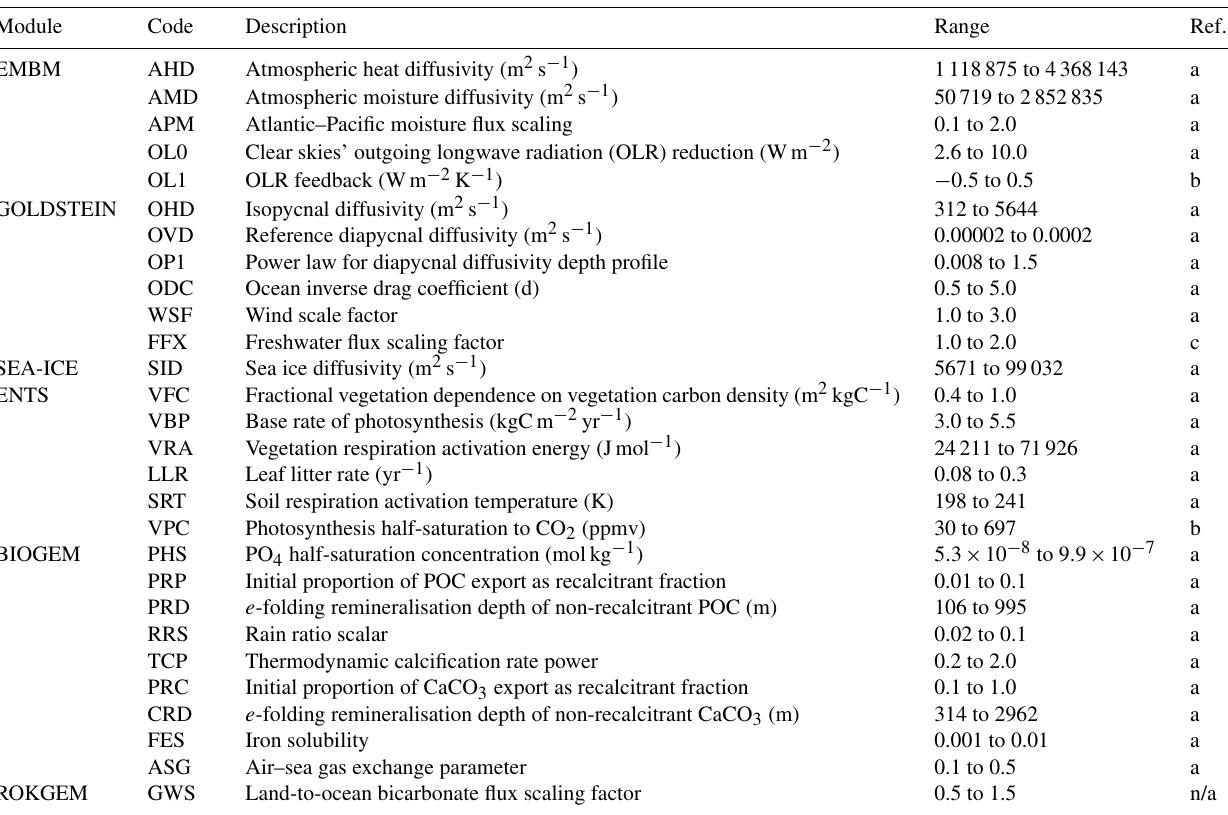
Table 1. Ensemble parameters. Ranges are from (a) Holden et al. (2013a), (b) Holden et al. (2013b) and (c) Holden et al. (2010b), with the exception of GWS (see main text). The table also precludes the dummy